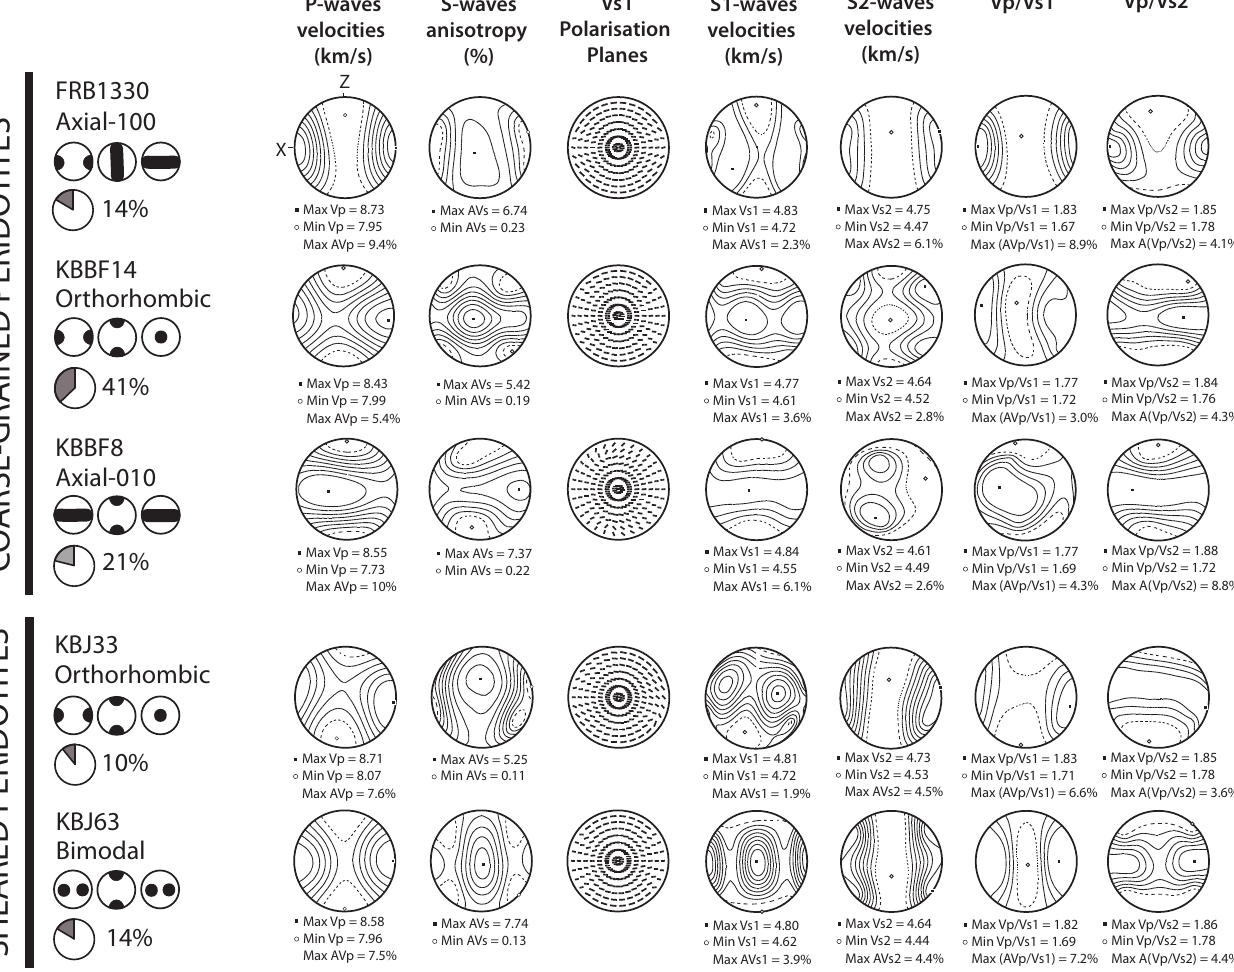
) , S 2 wave velocities ( V S ), V p /V S , and V p /V S . Black squares and white spots indicate 1 2 1 2